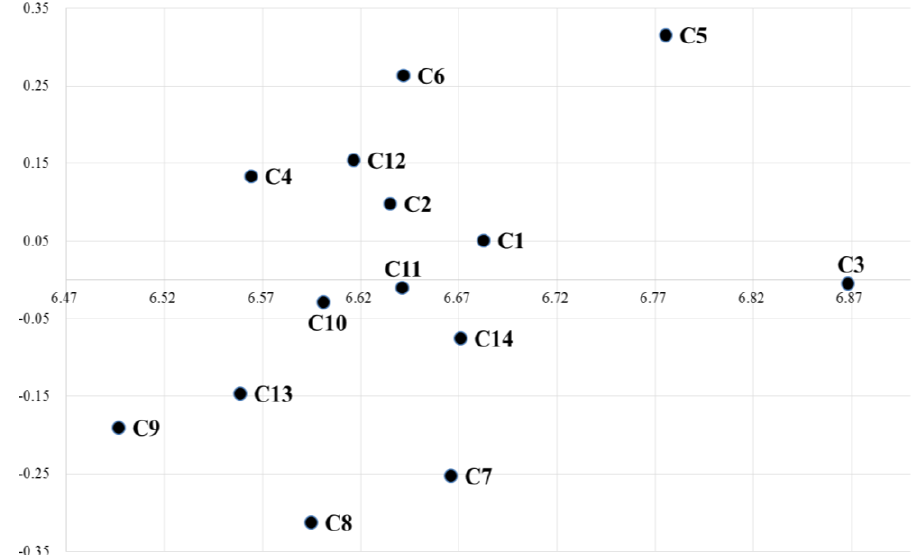
Figure 2. The cause and effect relationship diagram. C1, Marketing mix elements; C2, Appropriate media; C3, Designing effective communication message; C4, Feedback system; C5, Meeting the needs of beneficiaries; C6, Providing more benefit than cost; C7, Consumer orientation; C8, Long-term planning; C9, Operation Process; C10, Information resources; C11, Market Selection; C12, Moderate research; C13, Monitoring and adjustment; C14, Organizational advantage.